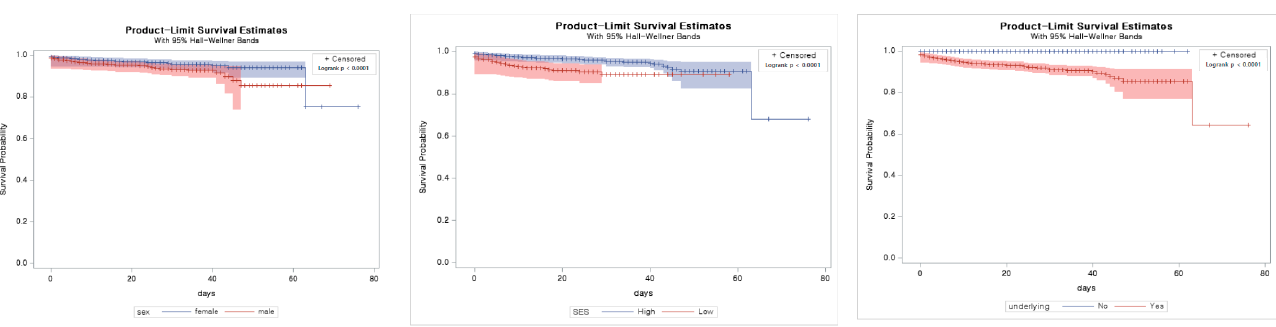
Figure 1. Kaplan–Meier Analysis of survival according to patients’ characteristics and conditions. SES socioeconomic status; underlying underlying disease.